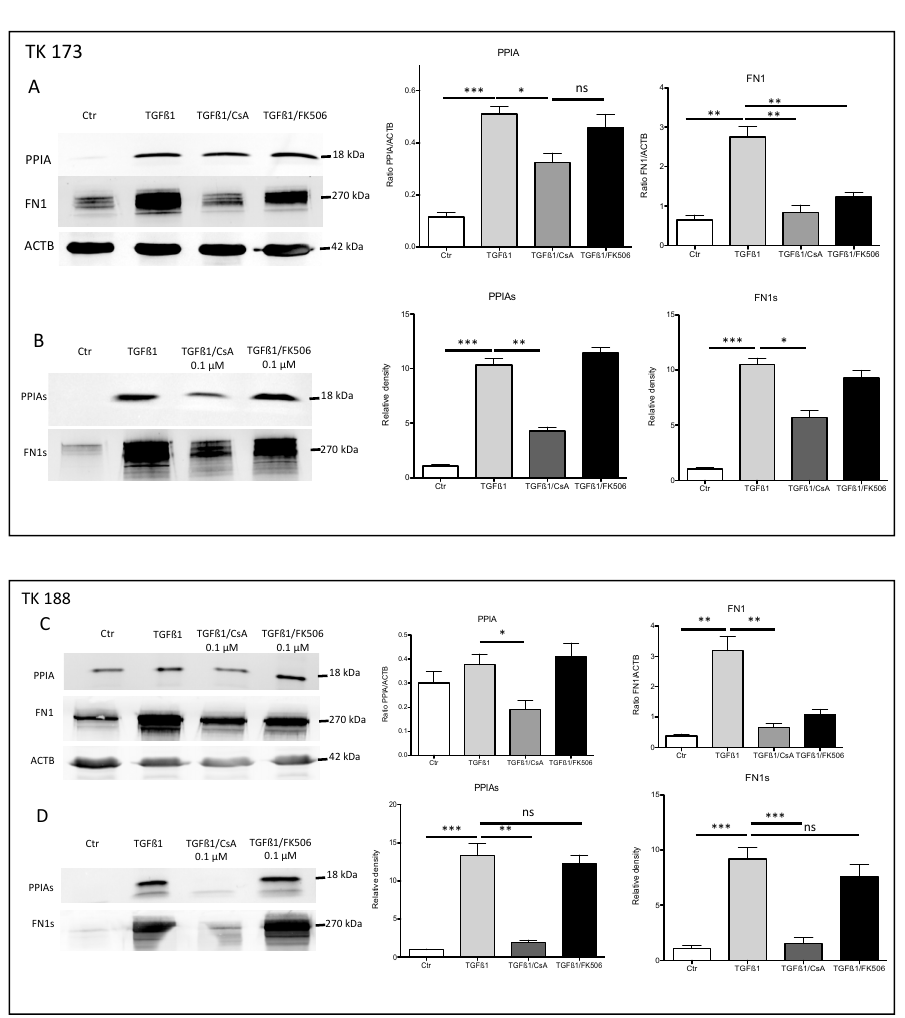
Figure 5. PPIA inhibition resulted in alteration of extracellular matrix (ECM) synthesis and secretion. TK173 was treated with TGF β 1 or TGF β 1 combined either with CsA or FK506 for 48 h. ( A , B ) The proteins were isolated from cultured cells or supernatant as described in Section 2. The Western blots were performed with antibodies against PPIA, and FN1 for secretome samples in case of cell extract beta-actin (ACTB) was used as the loading control. A bar diagram representing the quantification of the Western blot results for cell extract data is presented as the ratio of the PPIA/ACTB or FN1/ACTB ( n = 4, * p < 0.05). For secretome samples, the data are presented in intensity (%). ( C , D ) Western blot quantification for the TK188 treatments. * p <0.05, ** p < 0.01, *** p < 0.001.